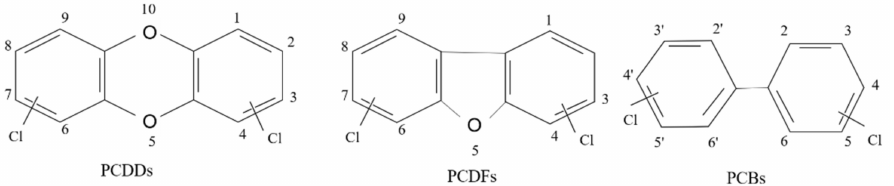
Figure 1. The basic structures of Polychlorinated dibenzo-p-dioxin (PCDD), dibenzofuran (PCDF), and biphenyls (PCBs).